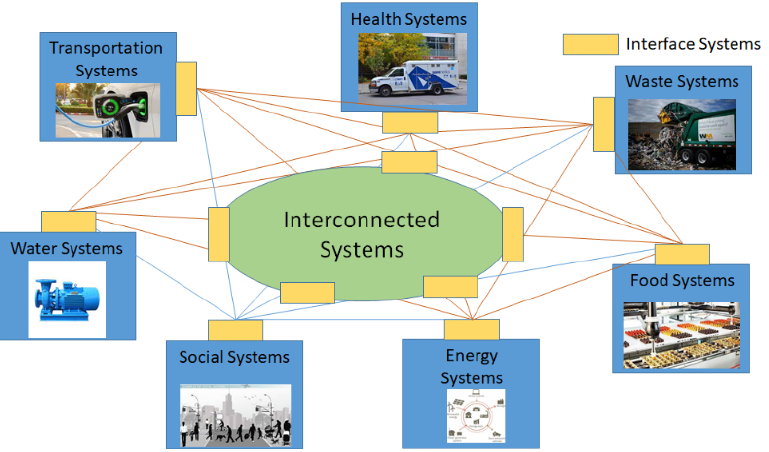
Figure 10. Example of interface system for interconnected systems.